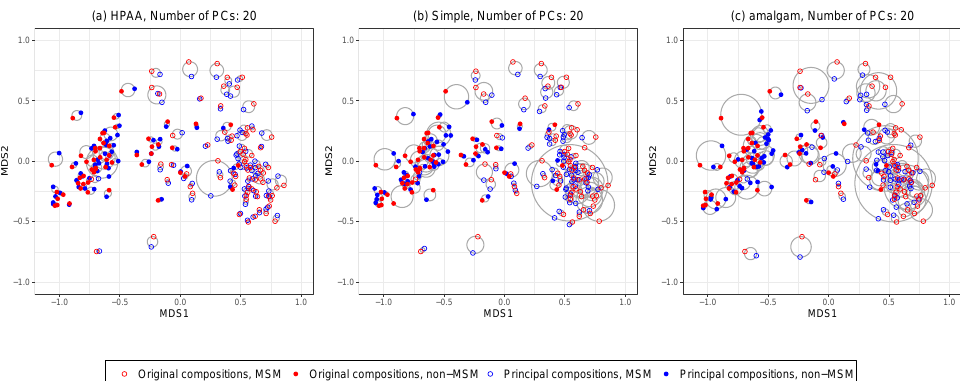
Figure 6. The HIV data: NMDS ordination plots for comparing original data and different principal compositions from different dimension reduction methods including ( a ) HPAA with Bray-Curtis and weak taxonomic hierarchy (HPAA), ( b ) simple approach (Simple), and ( c ) the amalgam method by Quinn and Erb